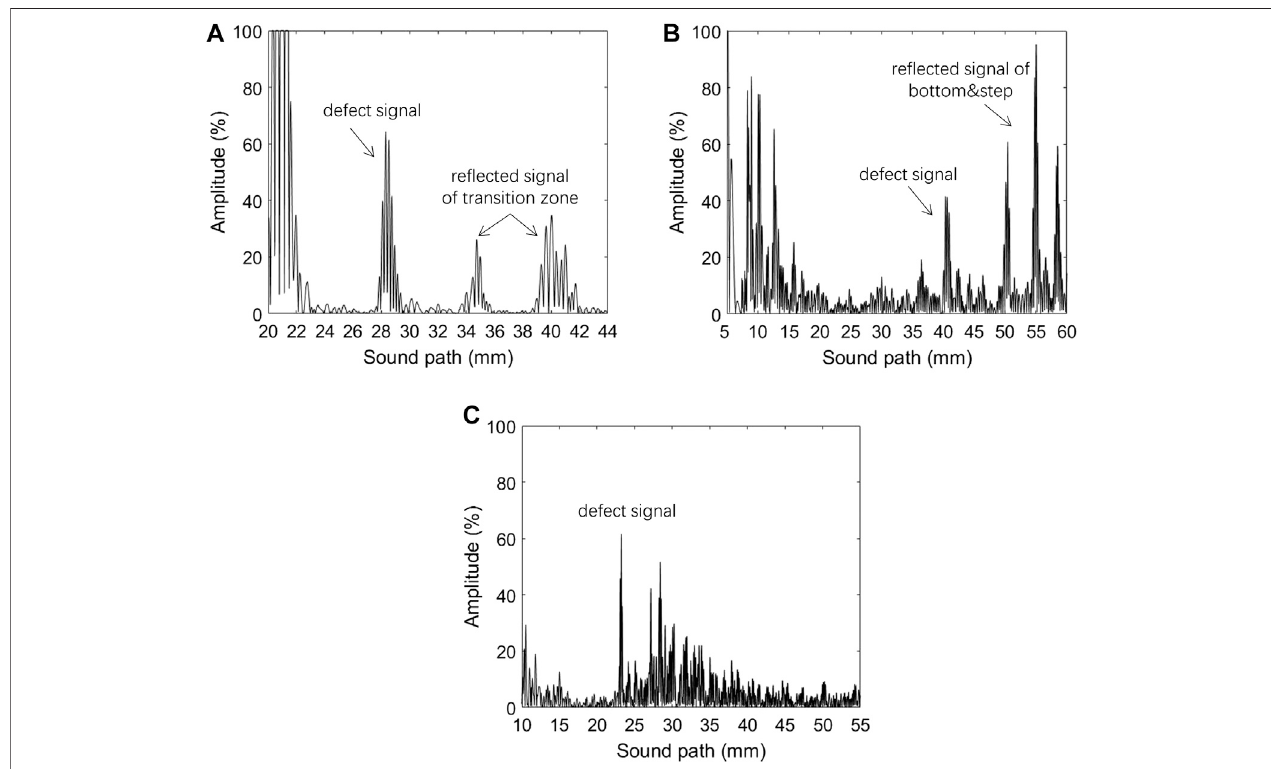
Figure 10B . For the detection of defects in the transition zone,